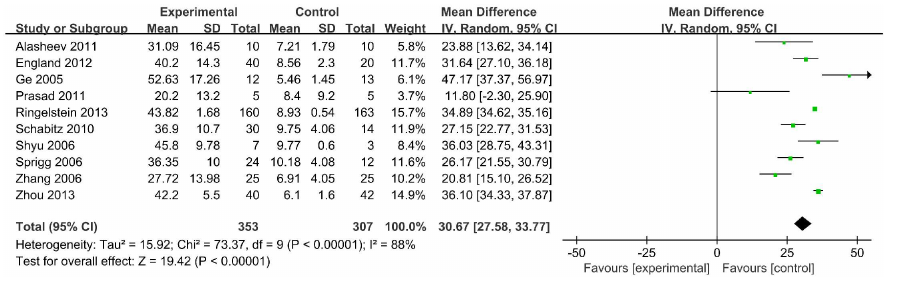
Fig 6. Leukocyte